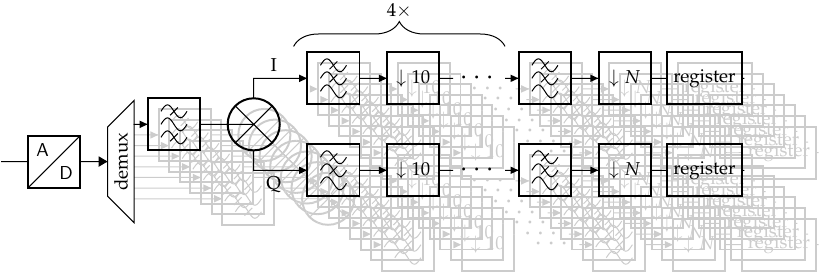
Figure 3. Schematic representation of the data processing and flow on the microcontroller of the Planalta board. The data coming from the analogue-to-digital converter ADC contains data from all channels. These samples are copied to new vectors by a “demultiplexer” (demux) to make the filtering faster. The incoming data is then band-pass filtered before being mixed to remove unwanted signals that the mixer can map to the same frequencies. Afterwards, the data passes through four filter and decimation stages before its final filtering and decimation step. The decimation factor N depends upon the incoming data rate to achieve an output frequency of 1 kHz.